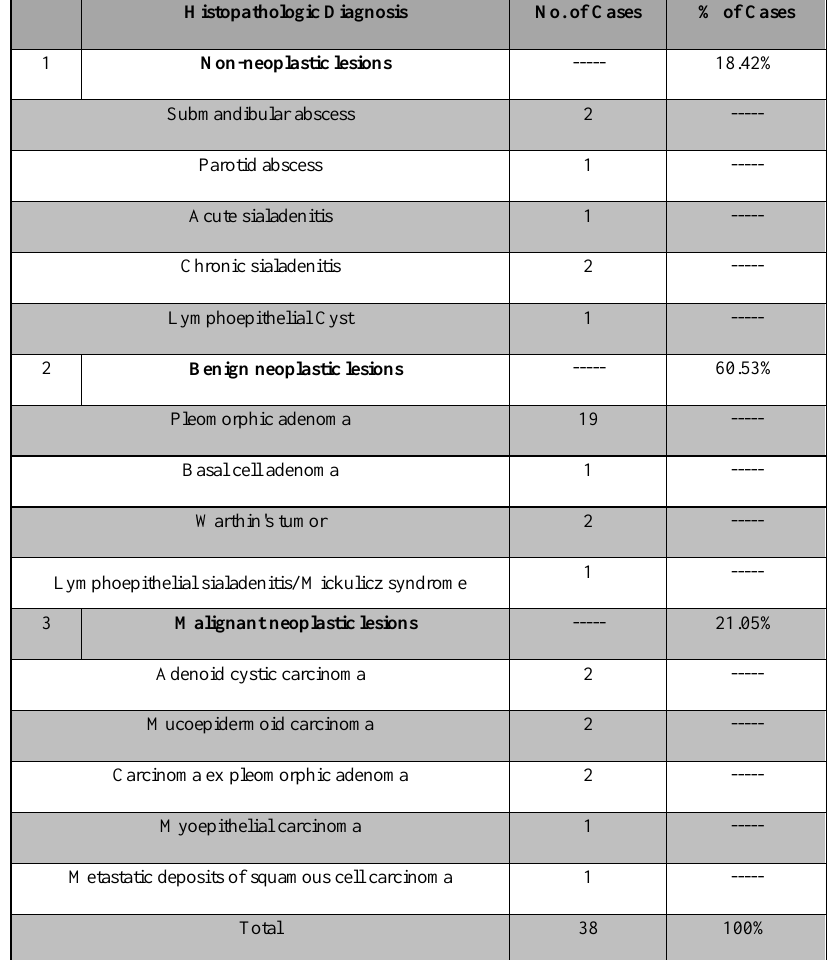
Table 4. Histopathologic diagnosis of salivary gland lesions(n=38).